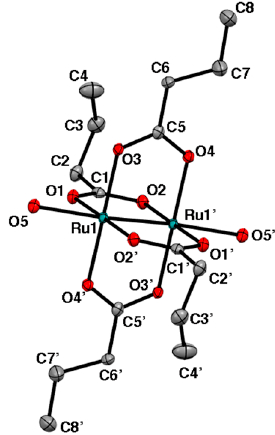
Figure 3. Structure of the cationic dinuclear unit of [Ru 2 (O 2 CC 3 H 7 ) 4 (H 2 O) 2 ]BF 4 ( 3 ). Hydrogen atoms were omitted for clarity. Primes ( ′ ) refer to the equivalent positions ( − x, − y, − z). The thermal ellipsoids are shown at the 50% probability level.